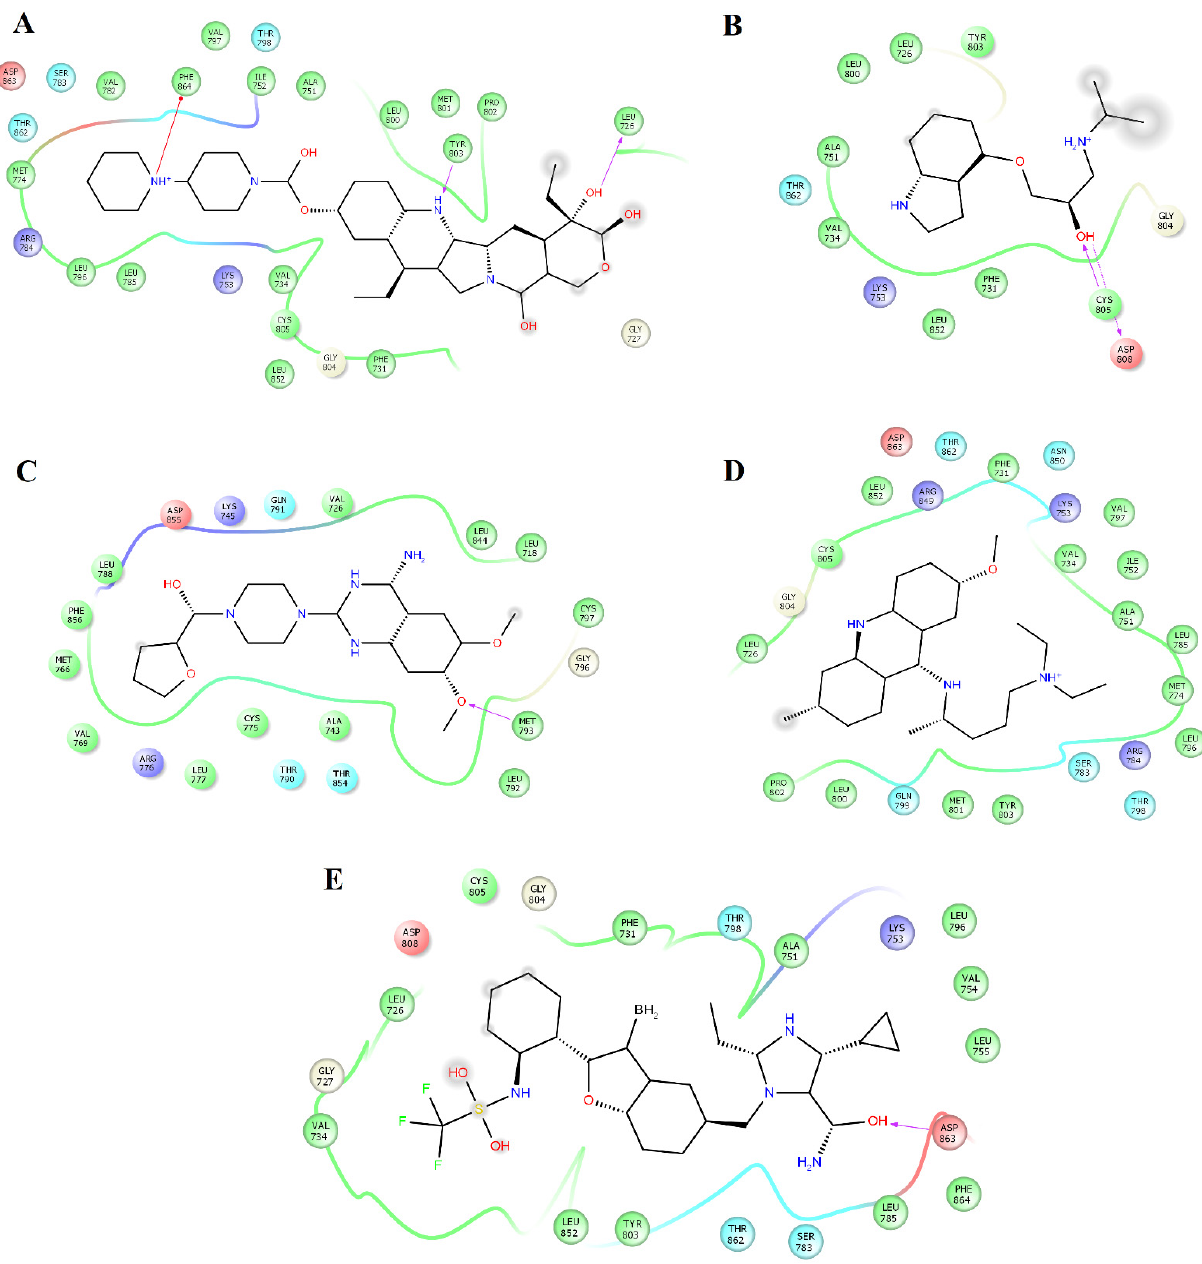
Figure 2. Map of interactions for the complexes between HER2 and irinotecan, pindolol, prazosin, quinacrine, and saprisartan. Binding conformations for HER2 irinotecan ( A ); HER2 pindolol ( B ); HER2 prazosin ( C ); HER2 quinacrine ( D ) and HER2 saprisartan ( E ).